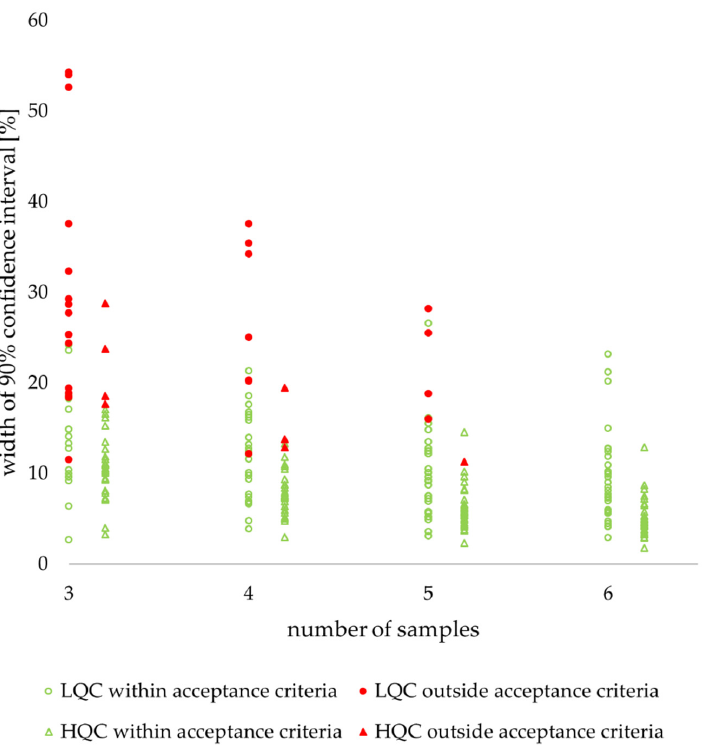
Figure 7. Retrospective study of nine drugs’ stability in human plasma: individual values of confi- dence interval width. LQC (circle)—low-quality control sample, HQC (triangle)—high-quality con- trol sample. Filled red figures indicate values outside acceptance criteria, unfilled green figures in- dicate values within acceptance criteria.